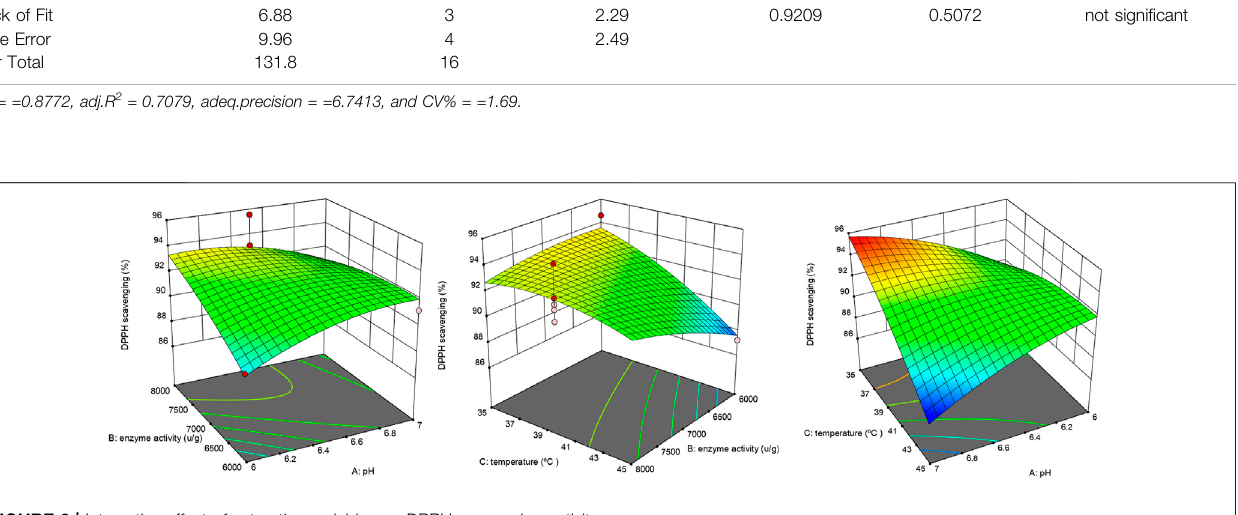
FIGURE 3 | Interactive effect of extraction variables on DPPH scavenging activity.